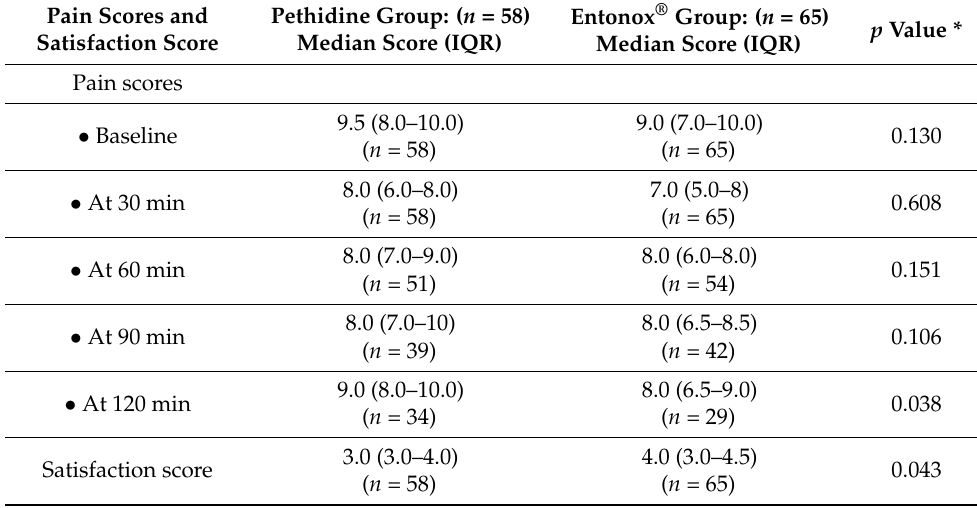
Table 2. Comparisons of pain scores and satisfaction score between the pethidine group and Entonox ® group.